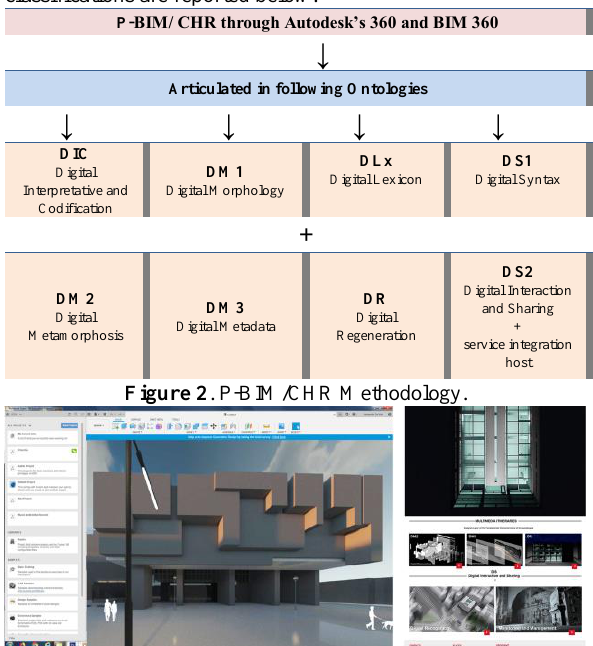
Figure 2 . P-BIM/CHR Methodology.